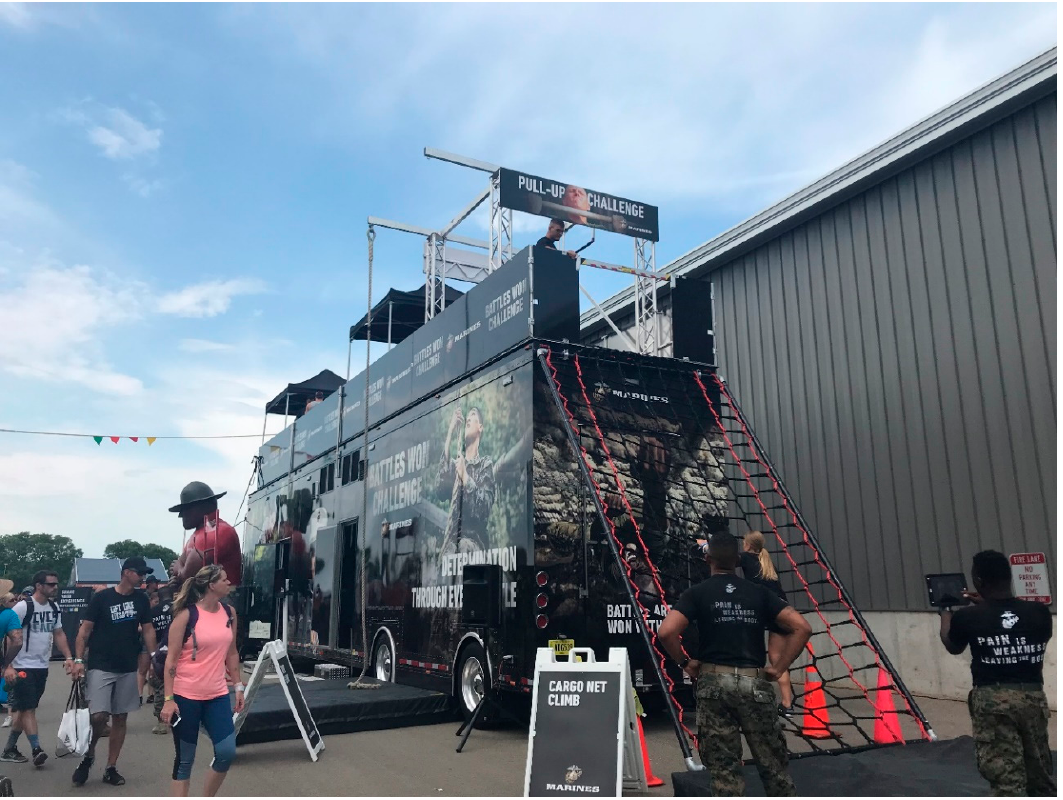
Figure 3. The Marines’ Battles Won Challenge mobile obstacle course at the 2018 CrossFit Games.